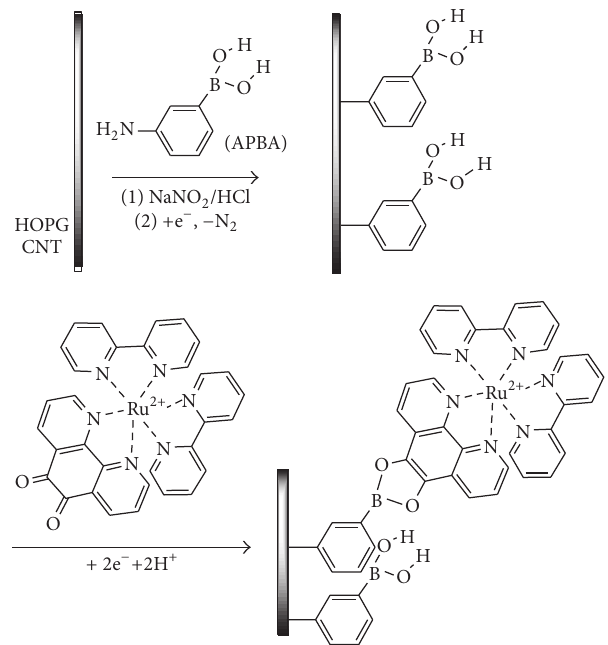
Scheme 1: Schematic illustration for the electrochemical attachment of APBA and Ru(bpy) 2 (phendione) 2+ to carbon